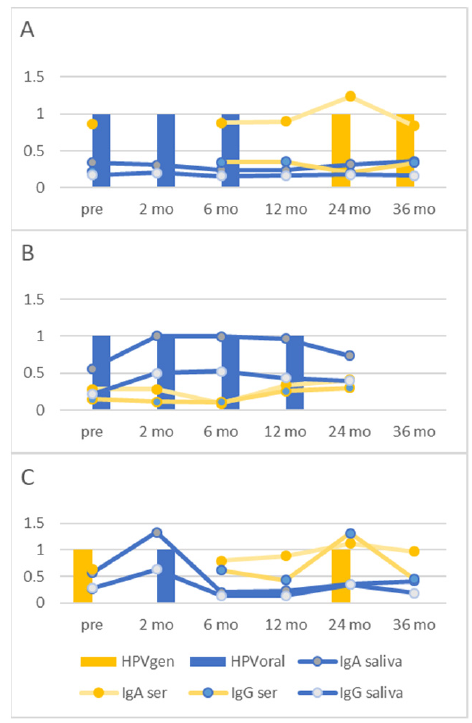
Figure 4. ( A – C ) Individual saliva and serum (s)IgA/IgG HPV16L1 responses to oral and genital Figure 4. Individual saliva and serum (s)IgA/IgG HPV16L1 responses to oral and genital HPV16 infections. The columns represent genital (HPVgen) and oral HPV16DNA (HPVoral) DNA HPV16 infections. The columns represent genital (HPVgen) and oral HPV16DNA positivity at different time points, and the lines show the levels of serum and saliva antibodies, (HPVoral) DNA positivity at different time points, and the lines show the levels of se- as rum and saliva antibodies, as indicated.